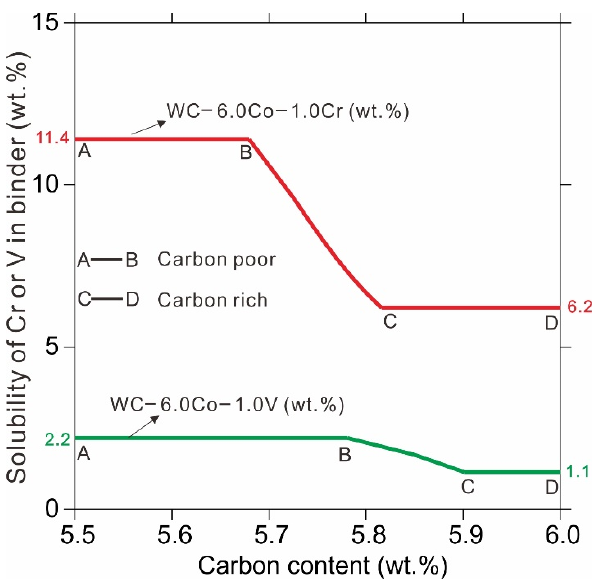
Figure 4. Calculated saturated solubility of Cr and V in Co binder phase based on the thermody- namic database developed by Peng et al.